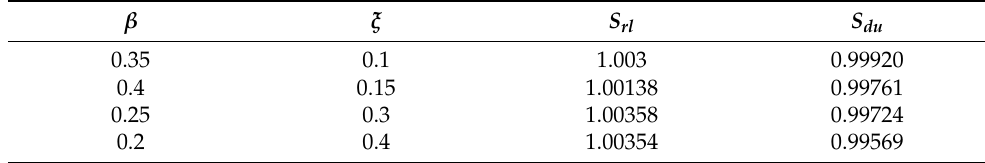
Table 1. Values of S rl and S du under different crack parameters. S and S under different crack parameters. Table 1. Values of rl du β ξ S rl S du β ξ S rl S du 0.35 0.1 1.003 0.99920 0.35 0.2 0.4 1.00354 0.99569 The contour lines of S and S rl du 003.1 = S and 9992.0 = S rl du